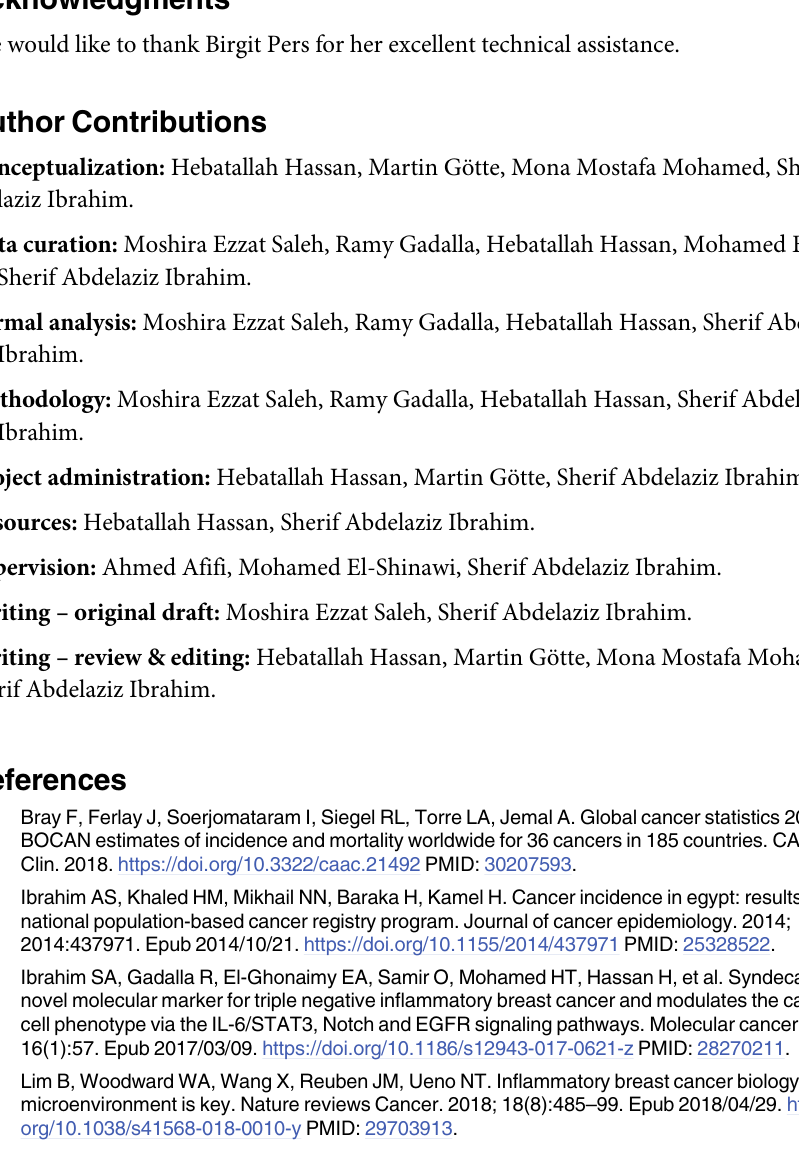
represent the mean ± SEM, n = 5, statistically significance is considered at P � 0.05 as deter- mined by Student’s t test. (TIF) S3 Fig. No significant differences for IL-4, IL-17, and Foxp3 mRNA expression in carci- noma tissue of non-IBC vs. IBC patients. Total RNA was extracted from non-IBC and IBC carcinoma tissue collected during surgical operation, reverse transcribed into cDNA, and rela- tive mRNA expression of a) IL4, b) IL-17, and c) Foxp3 were quantified by qPCR. RQ values of mRNA expression are log2 transformed and normalized to values of normal tissues col- lected during reduction mammoplasty. n = 15, P < 0.05 is considered significant as deter- mined by Mann-Whitney U-test.